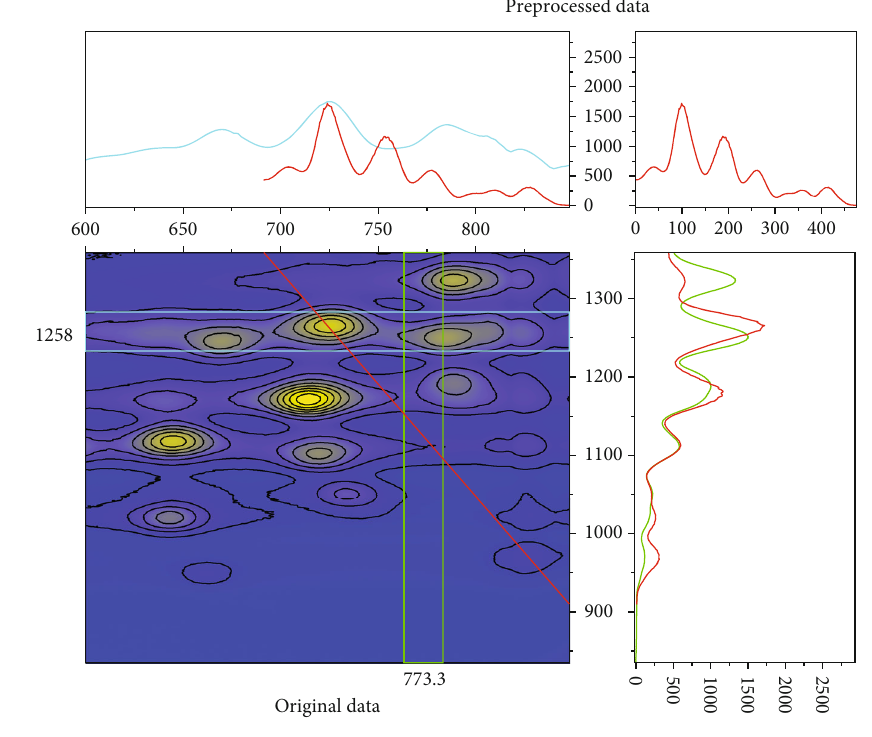
Figure 4: E ff ect of processing optical motion capture data.